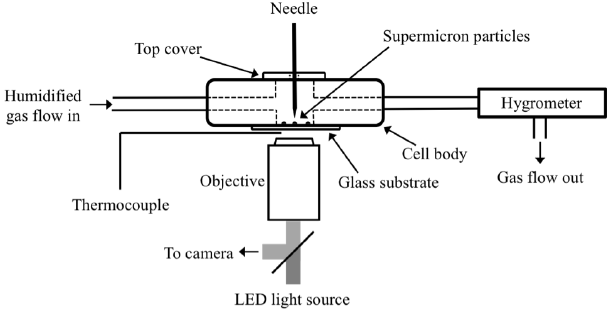
Figure 1. Schematic representation of poke-flow experimental